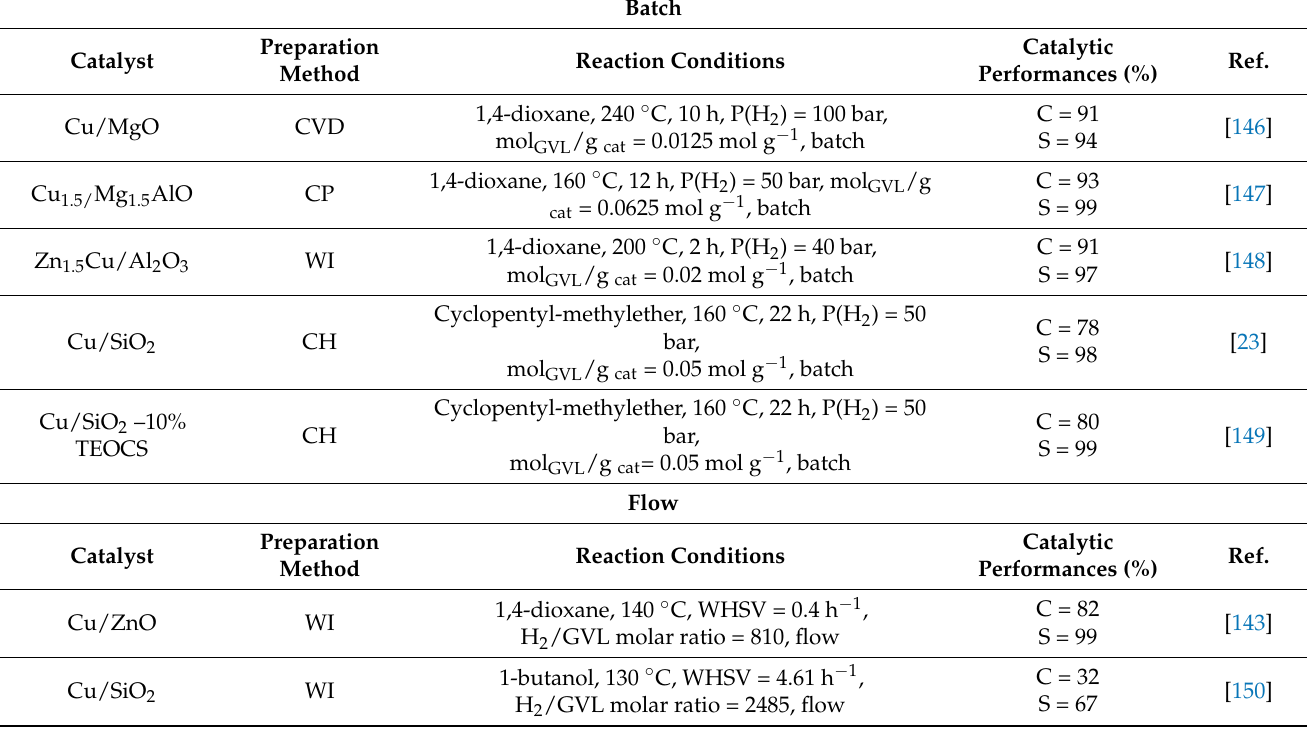
Table 4. Most relevant copper catalysts used for hydrogenation of GVL to give 1,4-PDO from the literature.